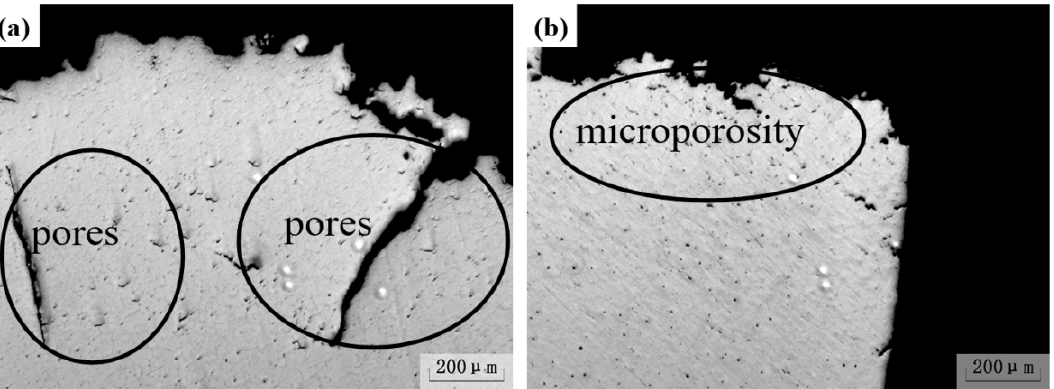
Figure 15. Cross-sectional microporosity of AZ91 alloy ingots by ultrasonic treatment. ( a ) 0 s; ( b ) 90 s.